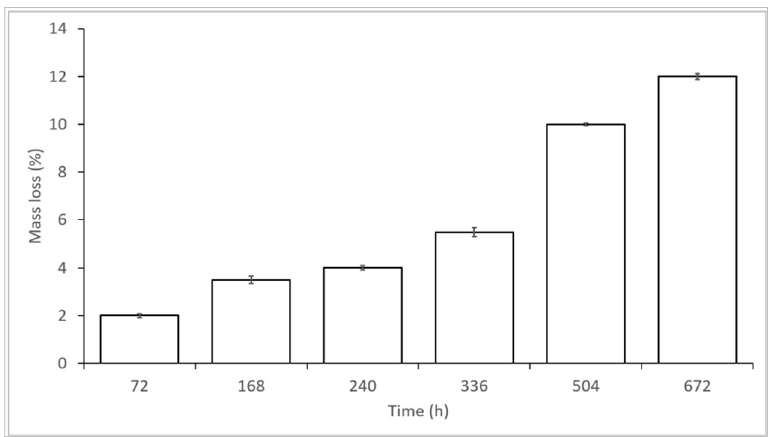
Figure 8. GS-loaded electrospun matrices’ mass loss percentage in simulated physiologic conditions (PBS, pH 7.4).